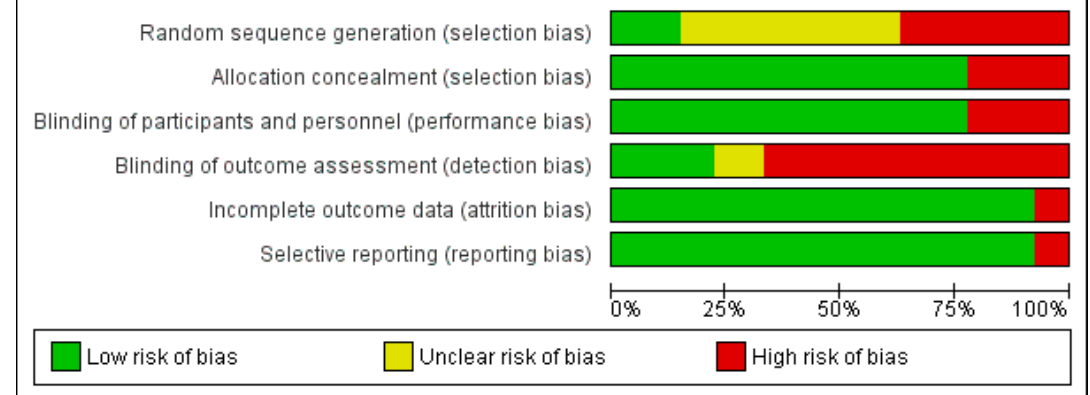
Figure 2. Risk of bias–estimation across studies.